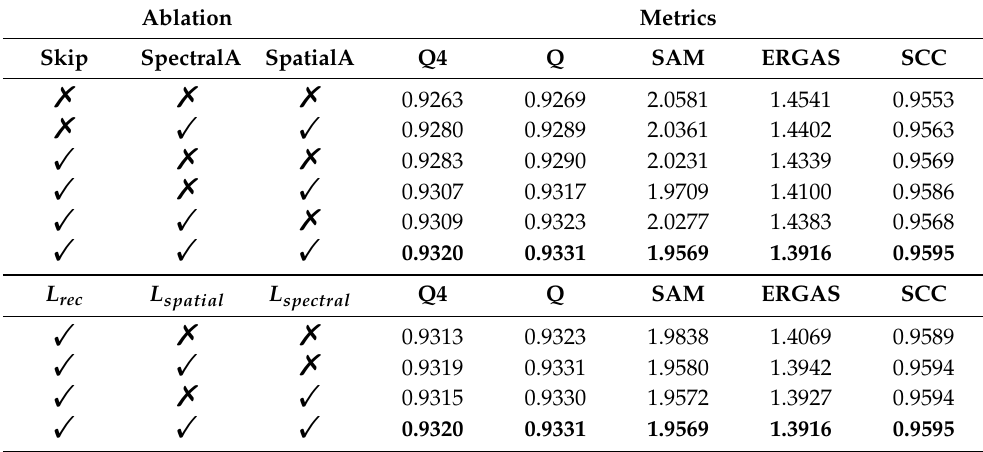
Table 6. Comparison of Fusion Performance on IKONOS Dataset Between Our Method and Its Degraded Versions. The Best Results are Shown in Bold